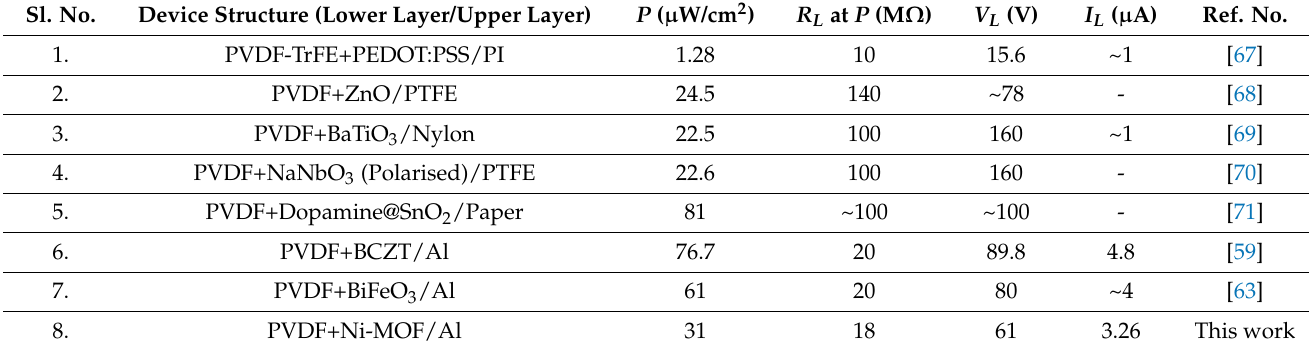
Table 4. Comparison of output power density ( P ), load voltage ( V L ), and load current ( I L ) of the fabricated NPVDFH device (HNG) with some other similar kinds of devices reported